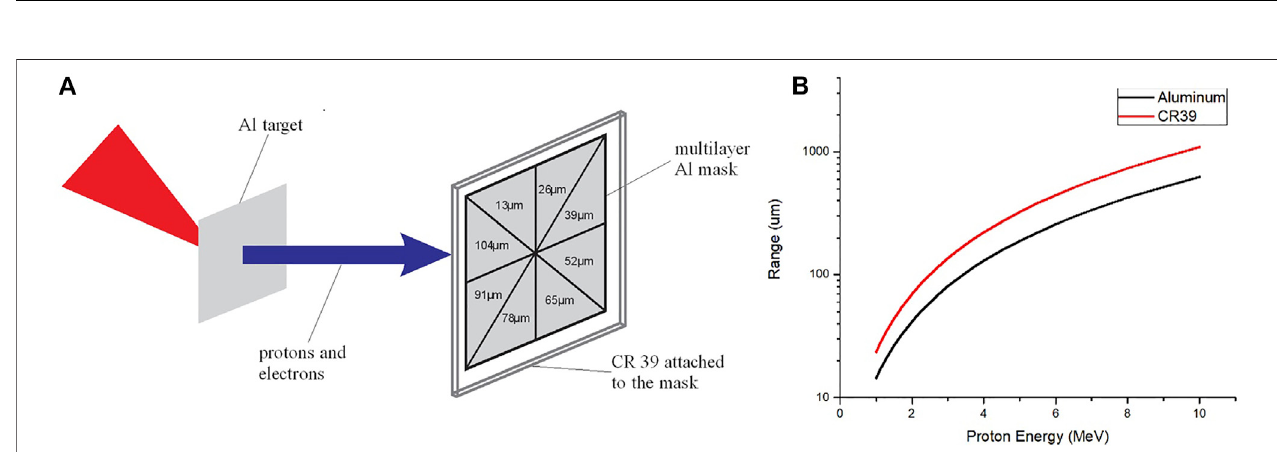
FIGURE 2 | (A) Schematic representation of the CR39 proton diagnostic fi ltered into 8 sectors by different thickness of Al foil. (B) Penentrating range of proton energies from 1 to 10 MeV inside aluminum and inside CR39 material.